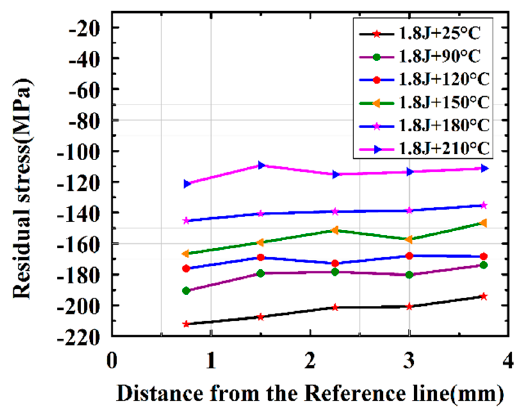
Figure 4. Surface residual stress distribution of WLP ‐ treated samples at different temperatures.